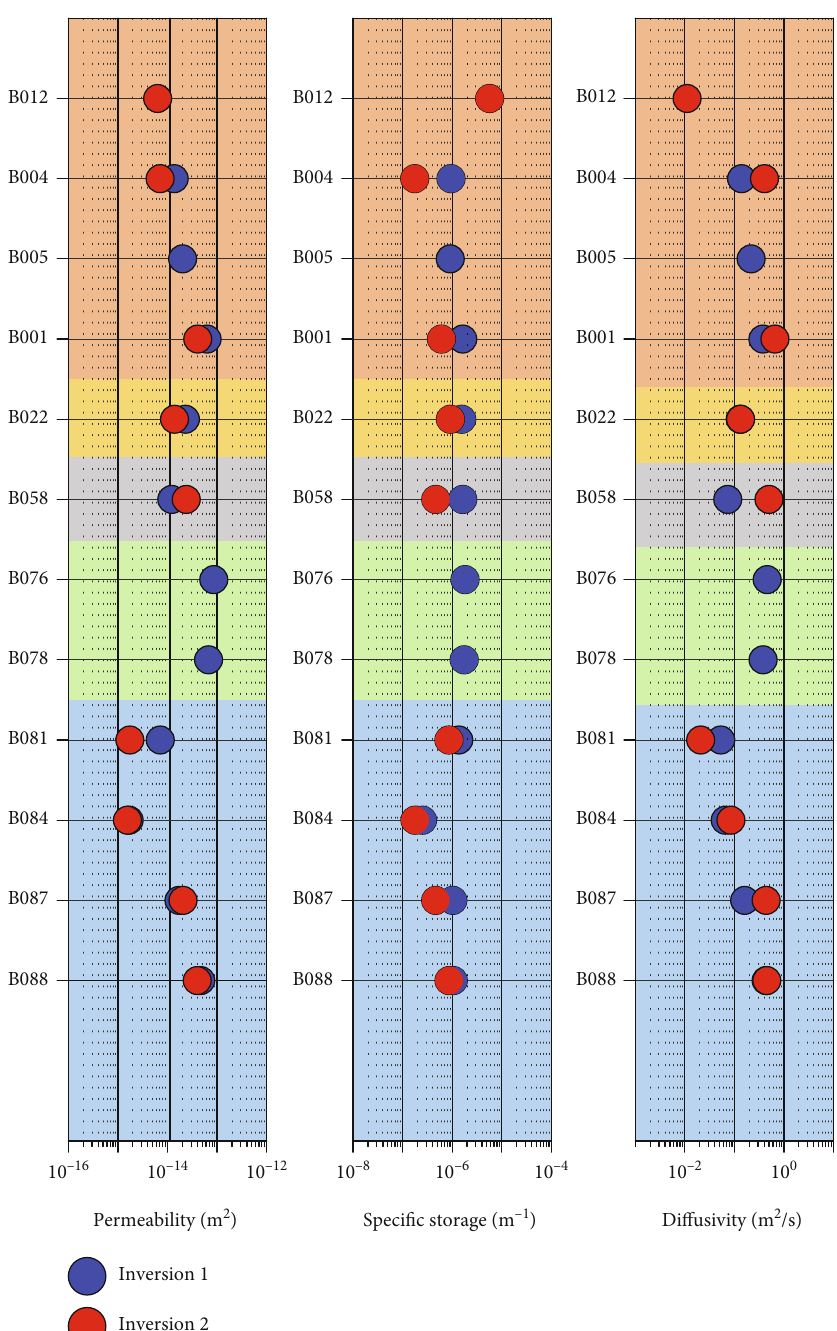
Figure 6: Median values of hydrologic properties. Wells are arranged descending to the south. Inversion 1 uses fi ltered borehole pore pressure and fi ltered modeled strain for analysis. Inversion 2 uses fi ltered borehole pore pressure and fi ltered strainmeter data for analysis. Background colors represent regions determined by geographic locality and similarity of local